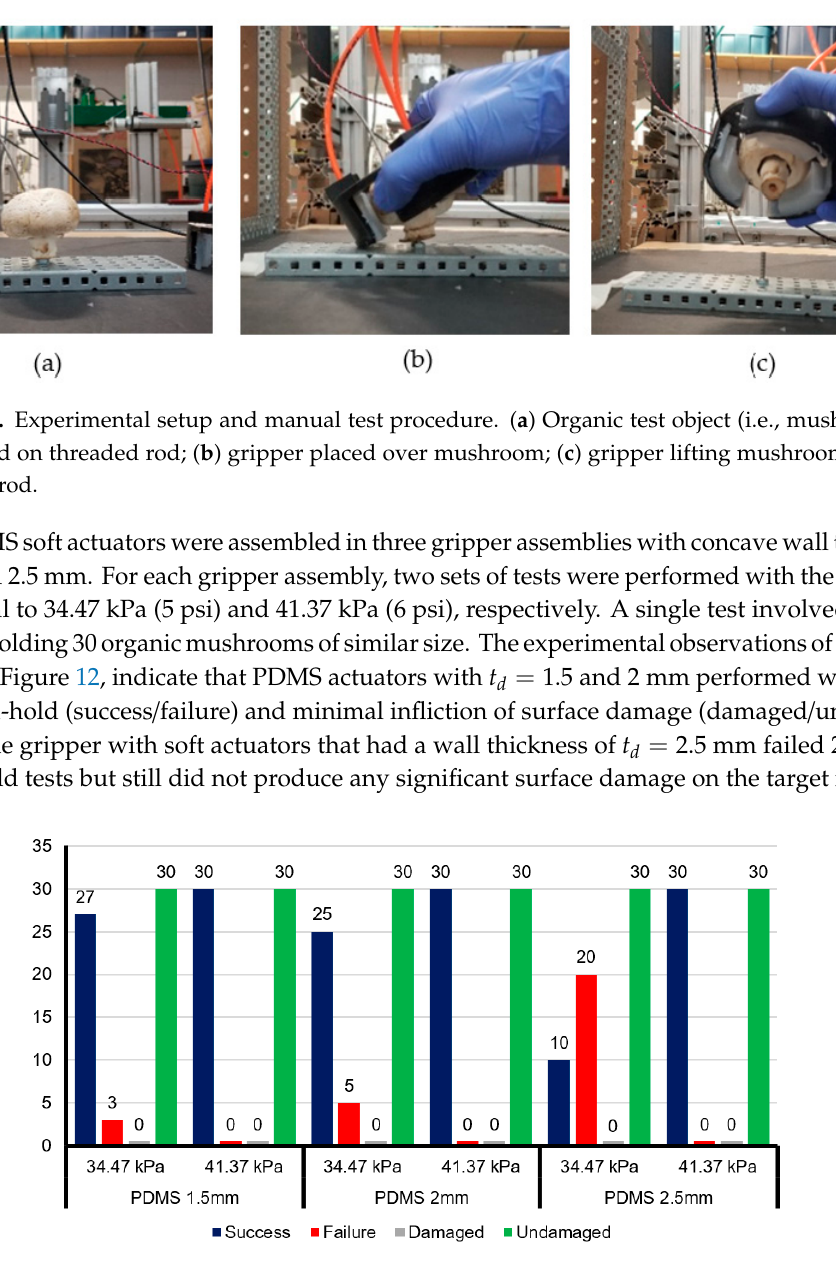
Figure 12. Results of grasp-and-hold experiments (success/failure) and observed damage to mushroom surfaces during the tests (damaged/undamaged).